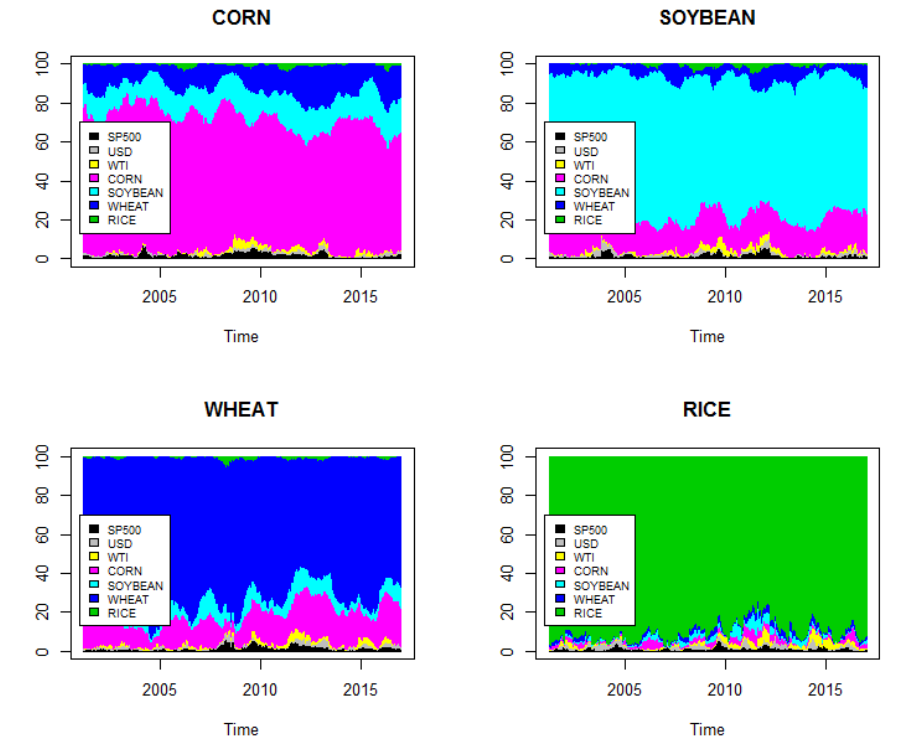
Figure 8: Forecast error variance decompositions of the food markets (the lasso